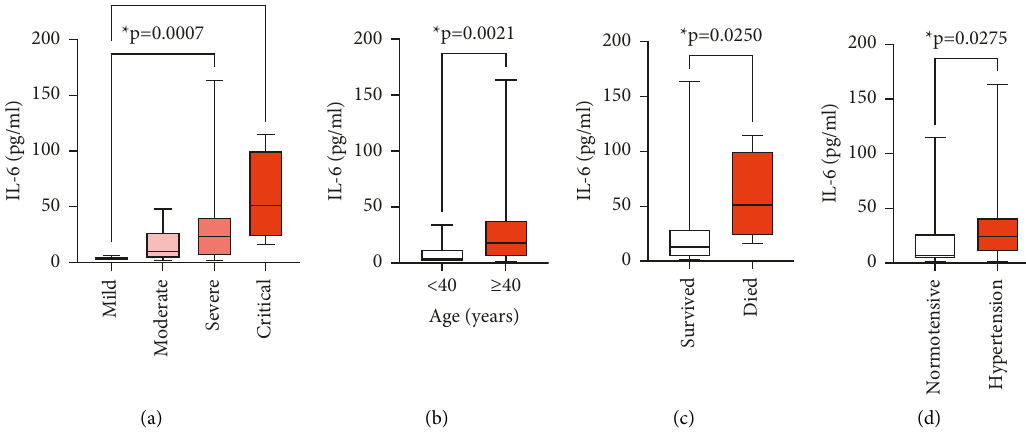
Figure 1: Distribution of IL-6 across the different groups of patients with SARS-CoV-2 whereas lower percentages of lymphocytes and monocytes and platelet count in more severe patients. In contrast, the distribution of D-dimer and CK did not show significant differences across the different disease severity groups al- though levels were higher in severe and critically ill patients (Table 4).